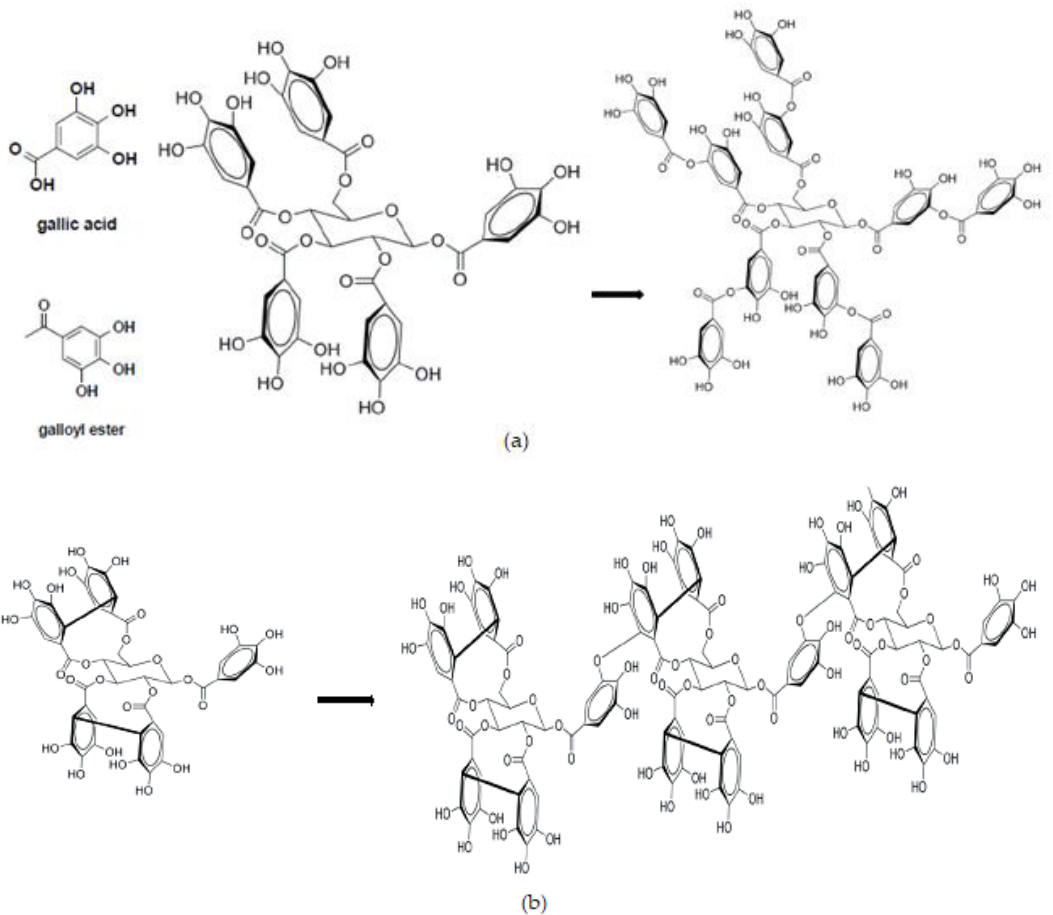
Figure 3. Model structure of phlorotannins. Source [24]. 3.2. Global Perspectives for Tannin-Containing Feeds